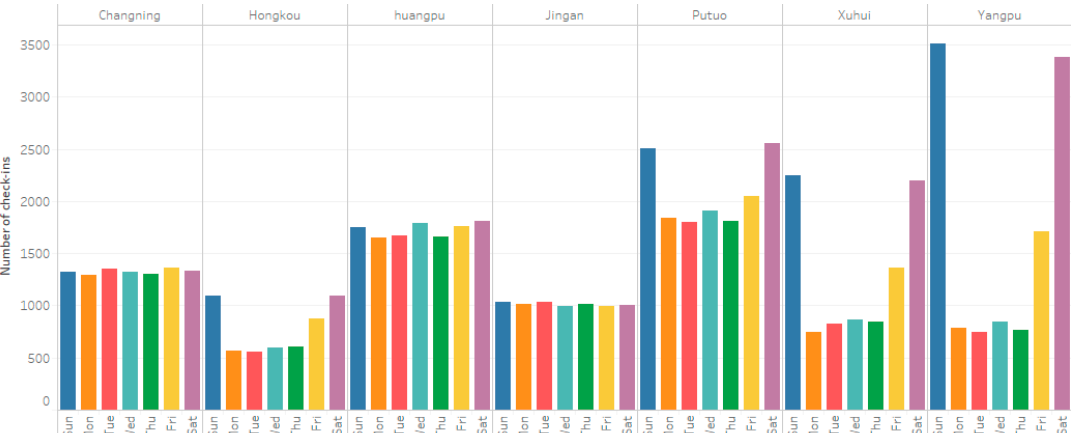
Figure 11. Weekly trends in green parks.